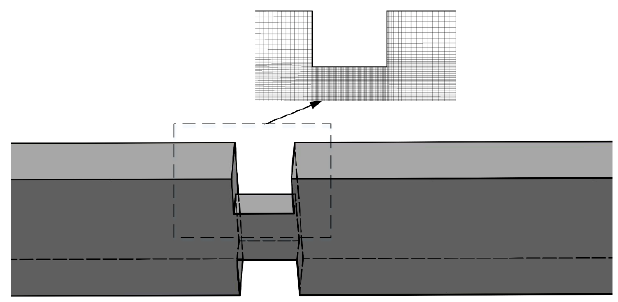
Figure 1. The geometry of the microchannel with micro-orifice.